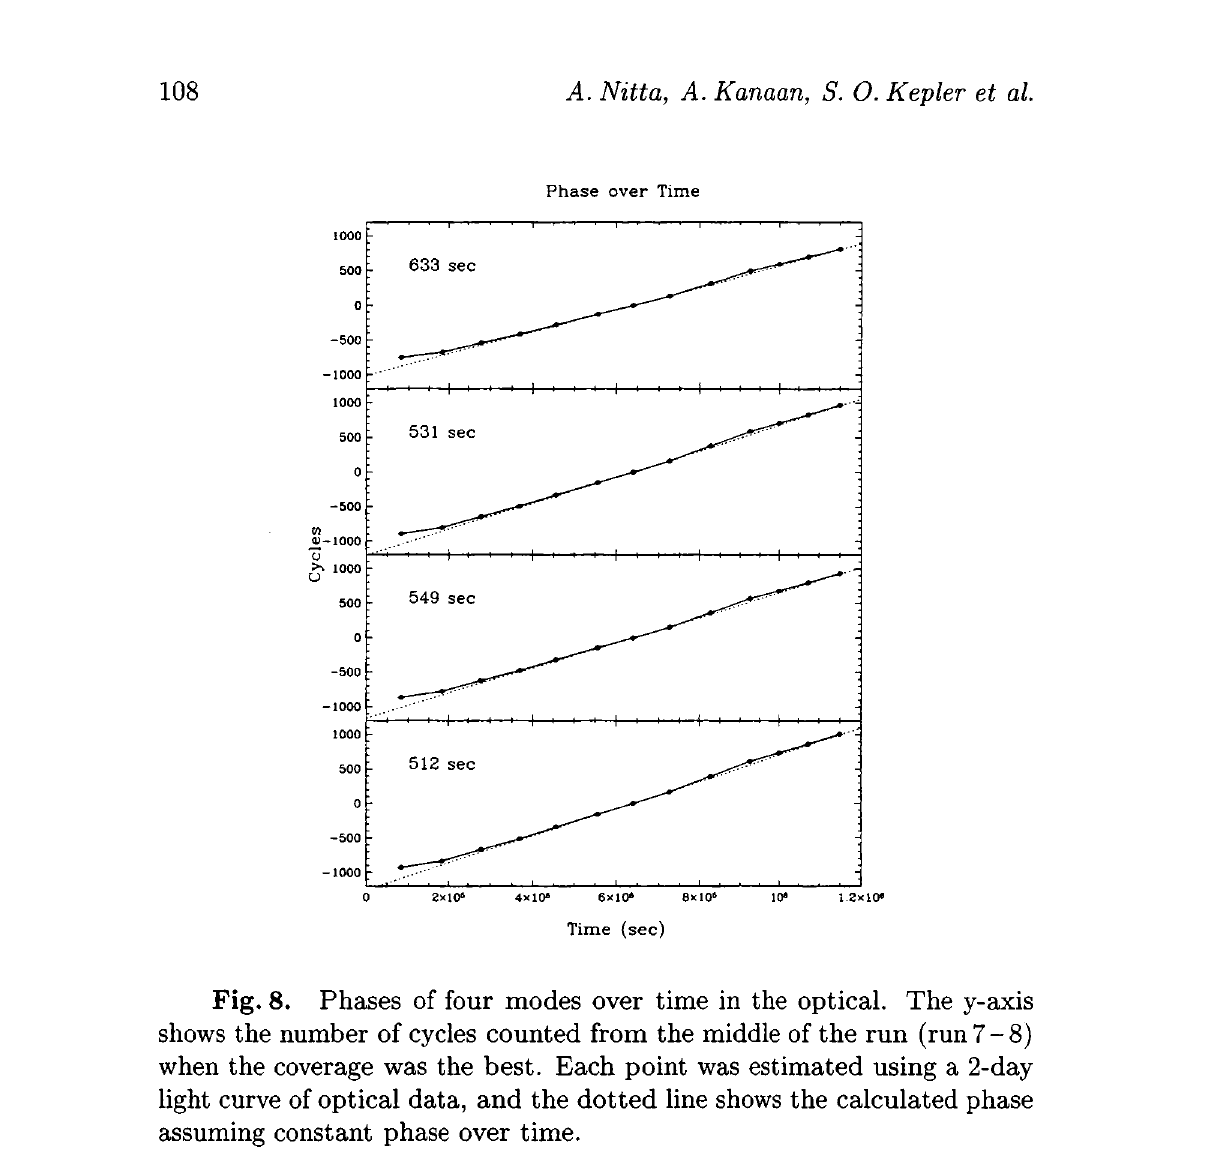
Fig. 8. Phases of four modes over time in the optical. The y-axis shows the number of cycles counted from the middle of the run (run 7 - 8) when the coverage was the best. Each point was estimated using a 2-day light curve of optical data, and the dotted line shows the calculated phase assuming constant phase over